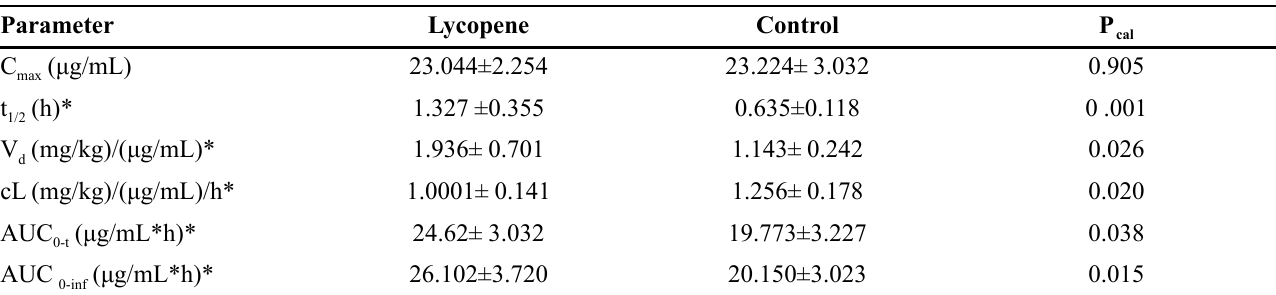
TABLE V - Statistical analysis of the results obtained by comparing the control group and lycopene group for the determination of